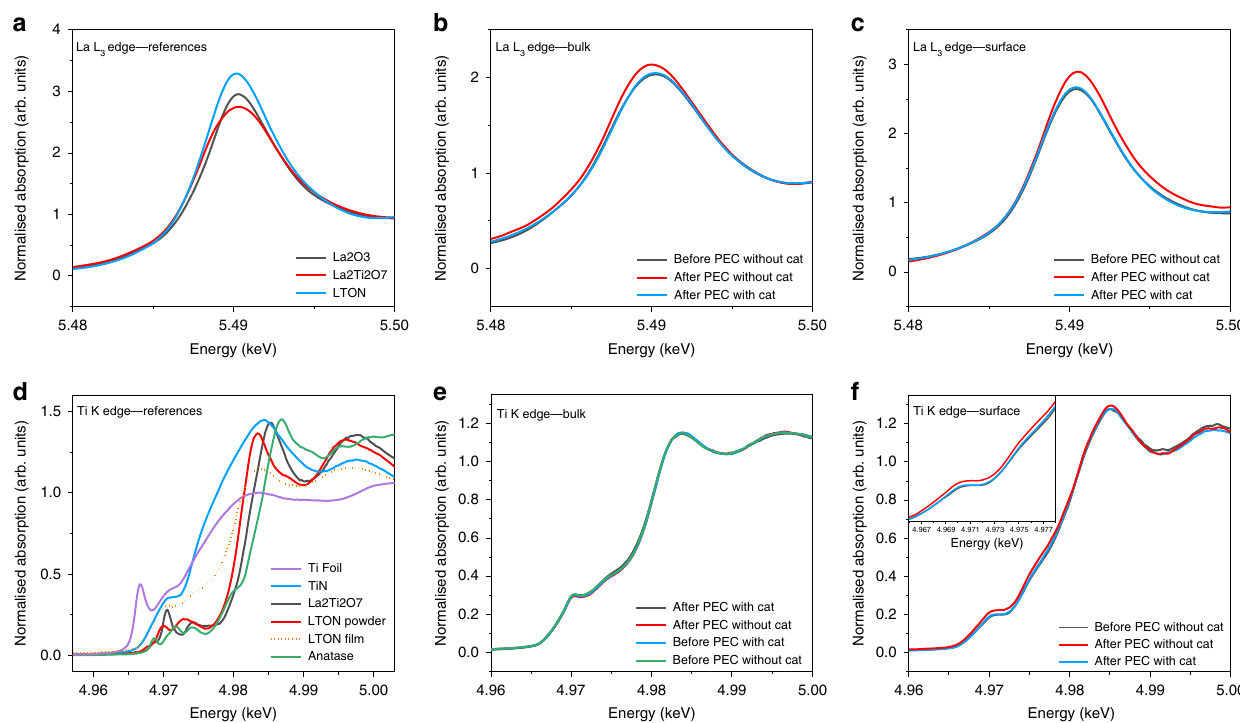
Fig. 5 XANES spectra for LTON measured at the La L 3 edge and Ti K edge with references. a La-containing references. b LTON bulk comparing La before and after PEC. c LTON surface comparing La before and after PEC. d Ti-containing references. e LTON bulk comparing Ti before and after PEC. f LTON surface comparing Ti before and after